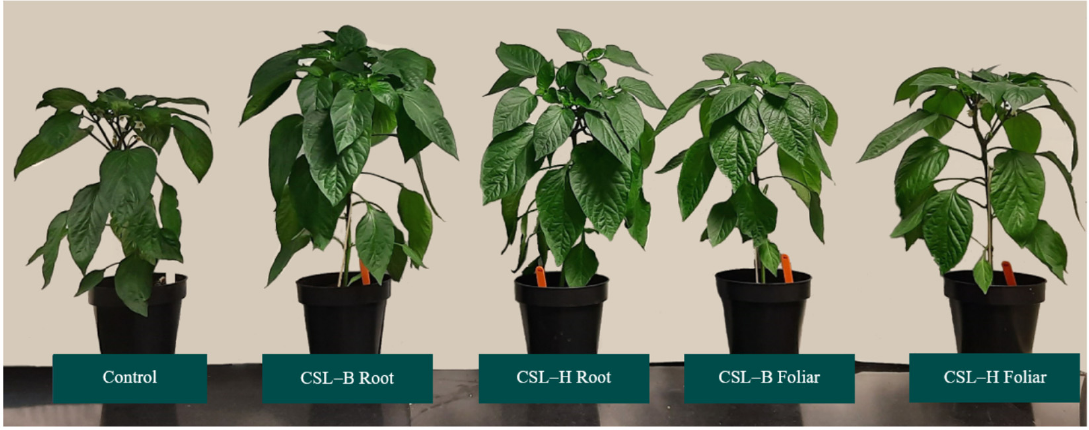
Figure 1. Appearance of the plants at the end of the experiment.